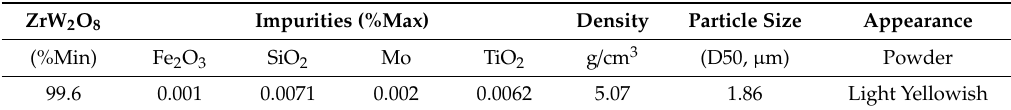
Table 2. Chemical composition and properties of ZrW 2 O